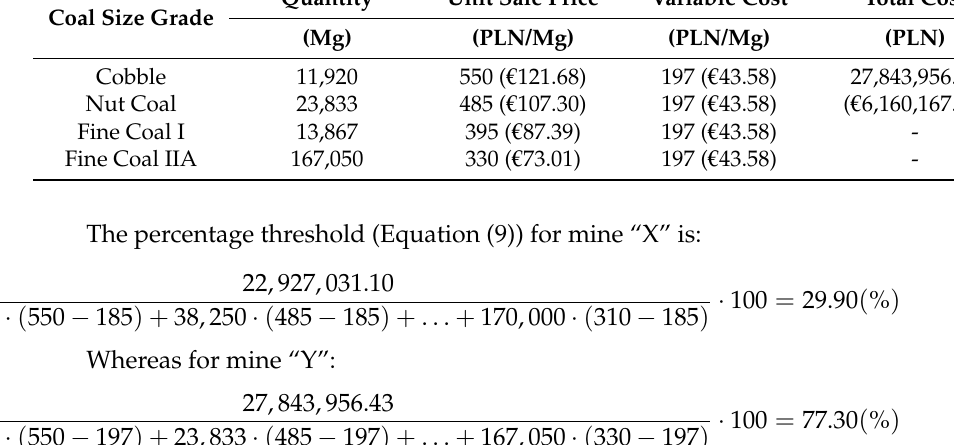
Table 4. Assumed value of production and economic indicators of mine “Y” in a monthly take. Coal Size